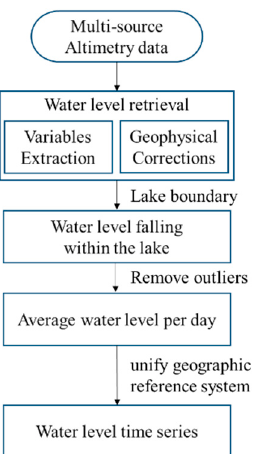
Figure 2. Flowchart of the combining multisource altimetry data.